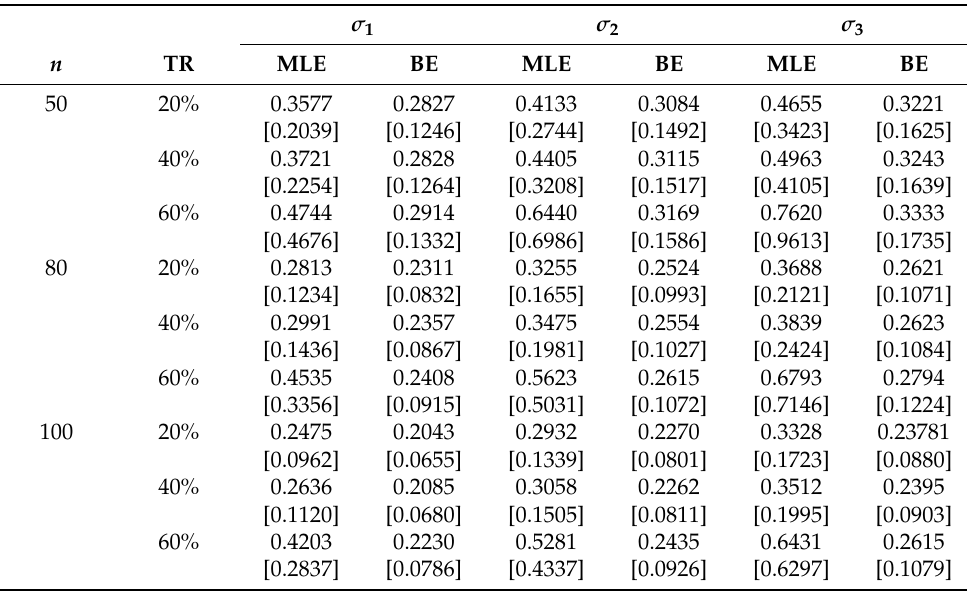
Table 1. ABs and MSEs (within bracket) for parameters without order restriction when ( σ 1 , σ 2 , σ 3 ) =